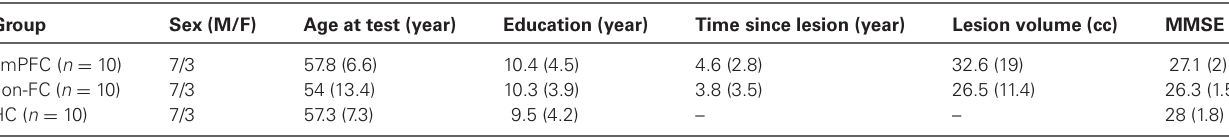
Table 1 | Summary data for participants [mean (standard deviation)] .